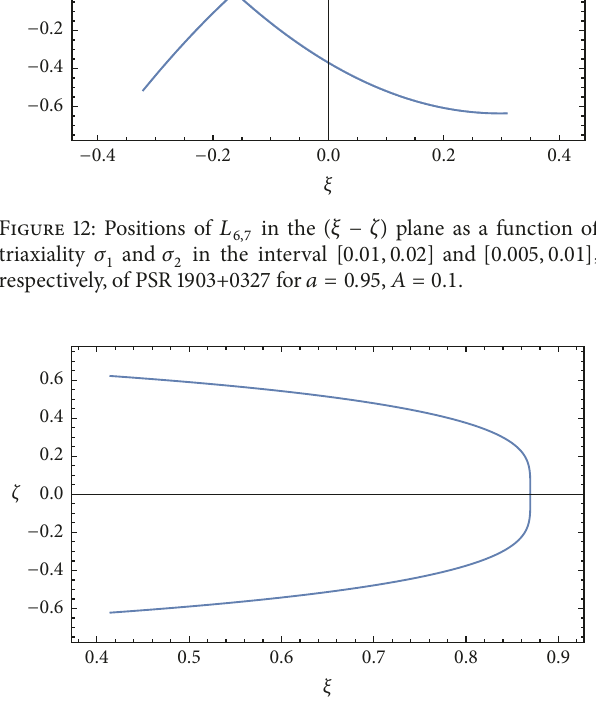
Figure 13: Positions of 𝐿 6,7 in the ( 𝜉 − 𝜁 ) plane as a function of oblateness 𝐴 in the interval [0,0.1] of DP-Leonis for 𝑎 = 0.95, 𝑒 = 0.2, 𝜎